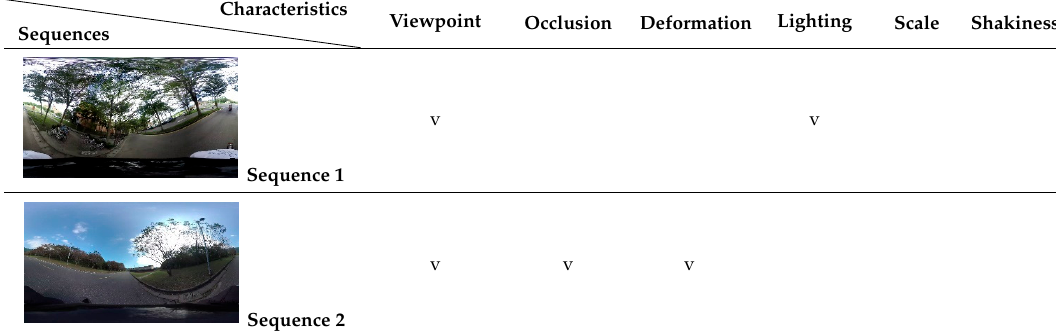
Table 1. Our dataset containing nine 360-degree videos, each with a combination of special characteristics.